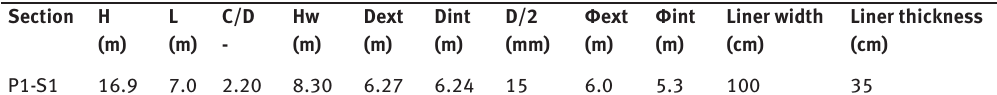
Table 1: Tunnel parameters.